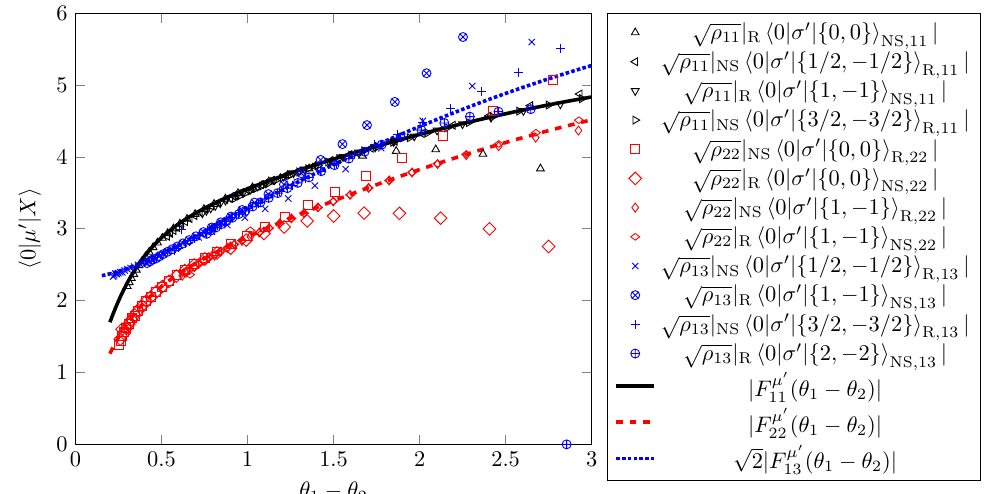
Figure 6.6: Rescaled vacuum-two-particle matrix elements of σ (cid:48) coming from TCSA in the low temperature phase plotted against the rapidity difference using discrete markers, and compared to form factors of µ (cid:48) in the high temperature phase shown with lines. The R / NS index corresponds to the sector from which the two-particle state is extracted; the vacuum state is always the ground state of the other sector. As discussed in Appendix C.2, the main source of error in this comparison are the expo- nential finite volume corrections to the matrix elements. States with larger Bethe– Yang quantum numbers realise the same rapidity difference in the larger volume, leading to smaller finite size corrections in this comparison.